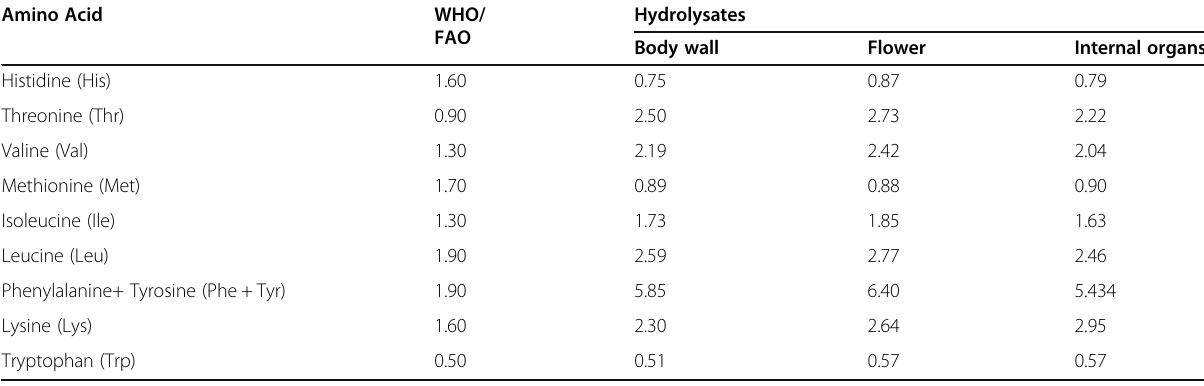
Table 4 Comparison of essential amino acid composition of protein hydrolysates from different body parts of the North Atlantic sea